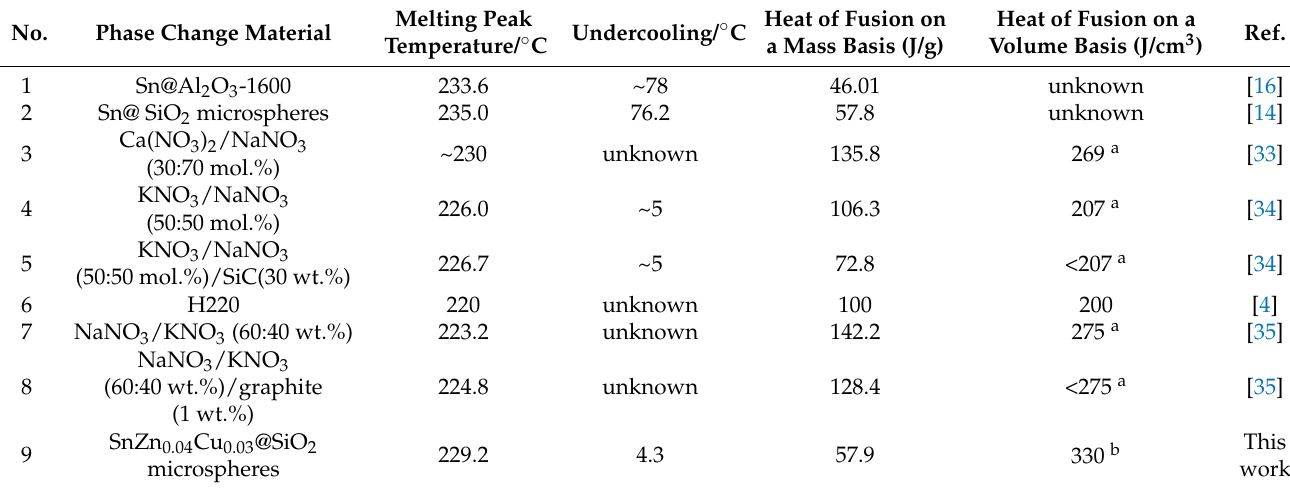
Table 1. A comparison between the properties of SnZn 0.04 Cu 0.03 @SiO 2 microspheres and some PCMs with a melting peak temperature ranging from 220 to 240 ◦